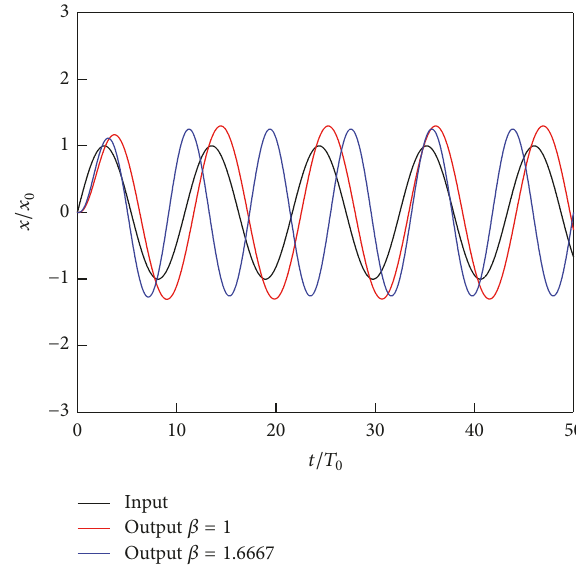
Figure 39: Response in the time domain ( 𝛼 = 3, 𝛽 = 1, 1.6667 , at resonance frequency).